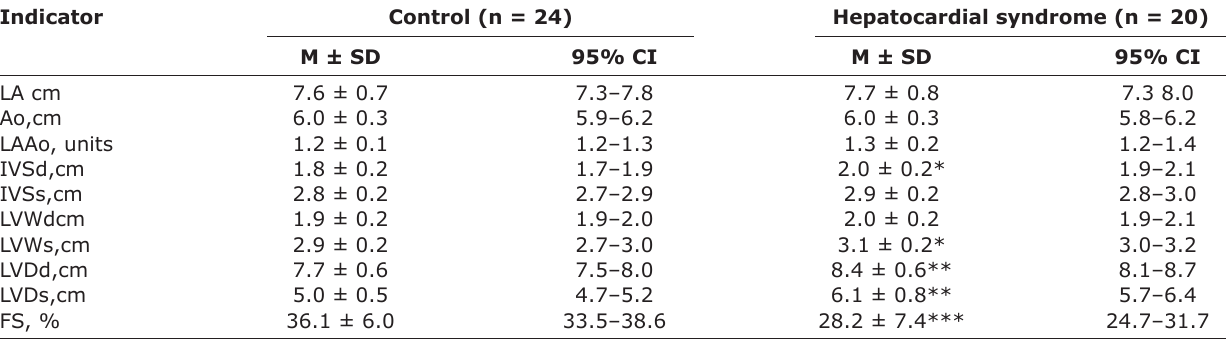
ba Figure-1: (a) Electrocardiographic parameters of healthy, highly productive cows (b) with the development of hepatocardial syndrome. Velocity 50 mm/s, voltage 1 cm/1 mV. Table-3: Echocardiographic parameters in cows with hepatocardial syndrome.